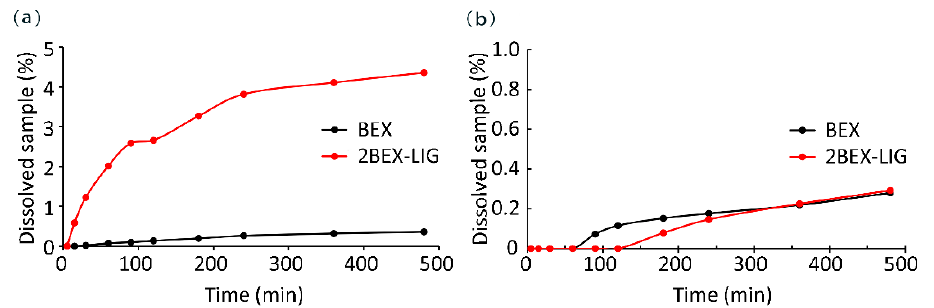
Figure 6. Powder dissolution profiles of bexarotene (BEX) and 2bexarotene-ligustrazine (2BEX-LIG) ( a ) in pure water and ( b ) in phosphate buffer saline (PBS).